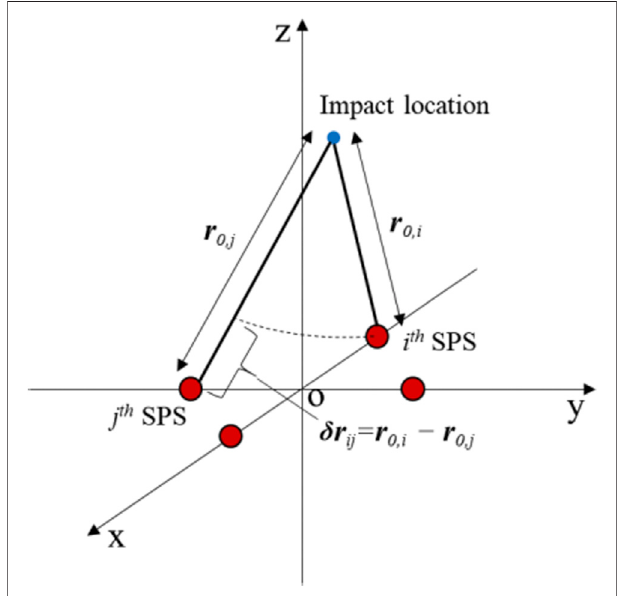
FIGURE 6 | Principle of the impact localization based on the diamond